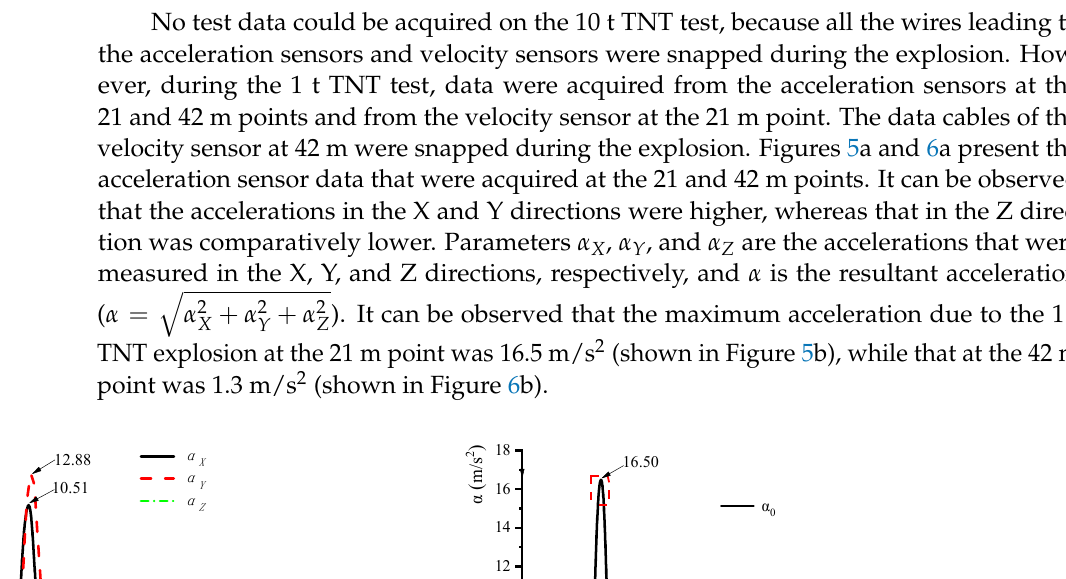
(cid:113) + α 2 + α 2 α 2 ( α = ). It can be observed that the maximum acceleration due to the 1 t TNT explosion at the 21 m point was 16.5 m/s 2 (shown in Figure 5b), while that at the 42 m point was 1.3 m/s 2 (shown in Figure 6b).